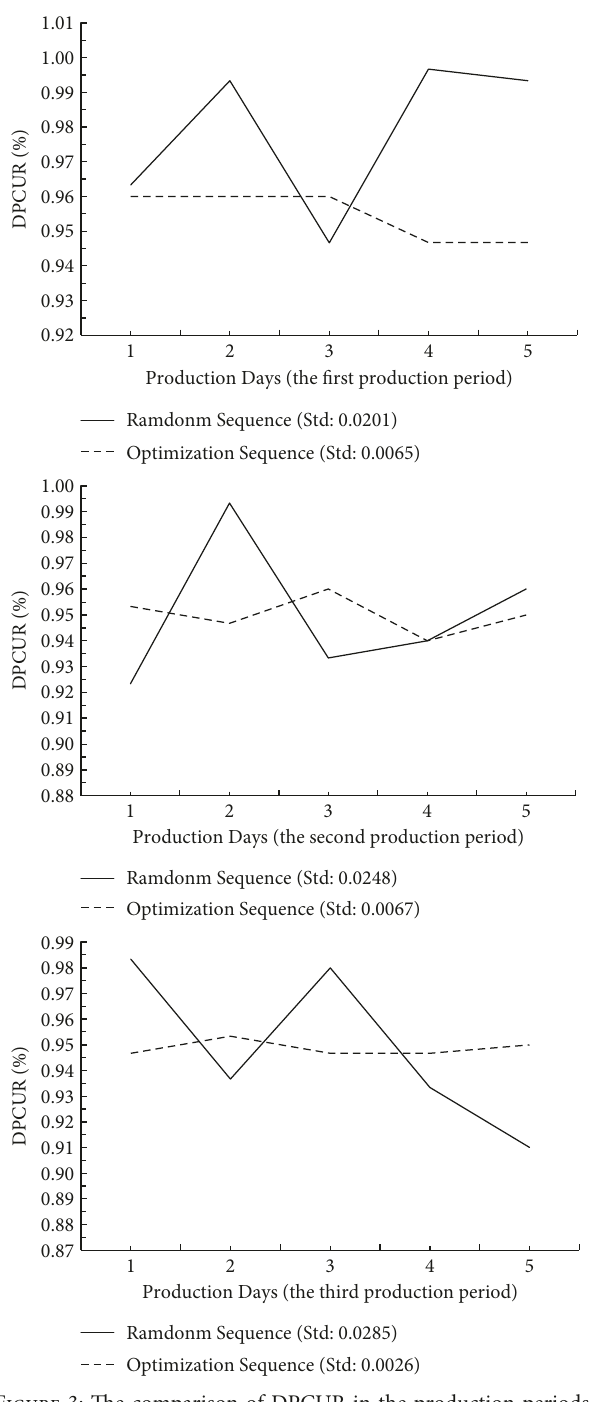
Figure 3: The comparison of DPCUR in the production periods.